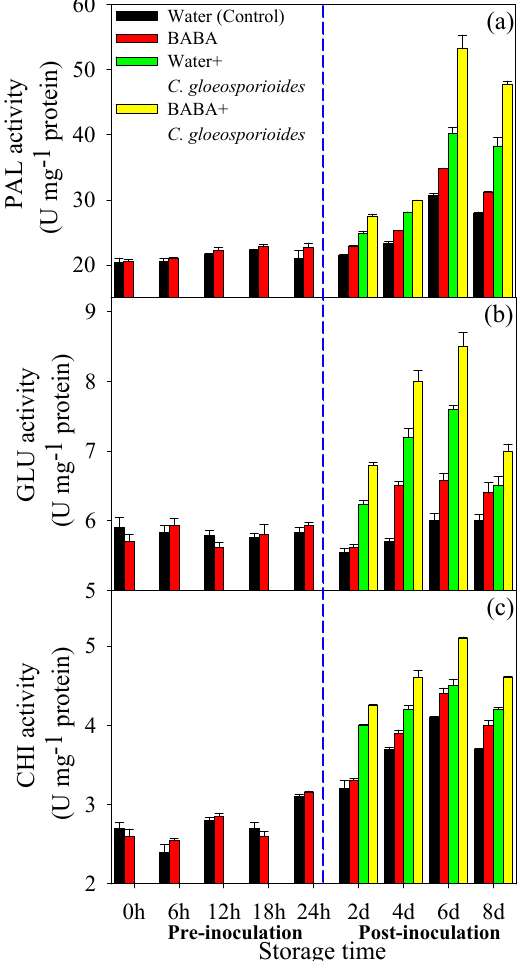
Figure 3. Effect of BABA treatment on β -1,3-glucanase (GLU) ( a ), phenylalanine ammonia lyase (PAL) ( b ) and chitinase (CHI) ( c ) activities in mango fruit. Data presented are means ± standard errors (n = 3).